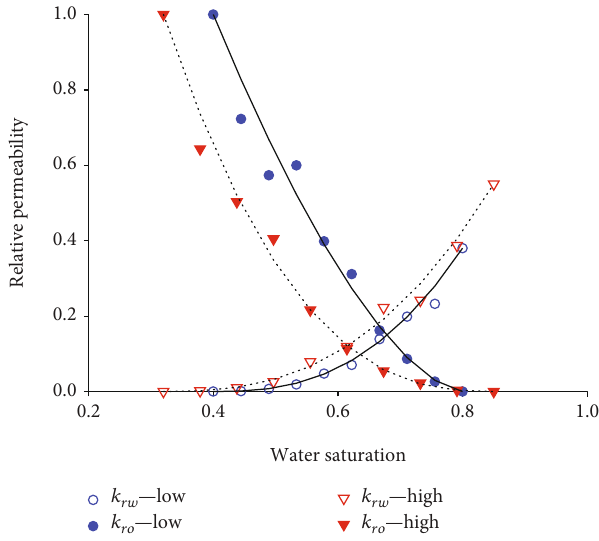
Figure 1: Relative permeability curves of cores with di ff erent permeability.